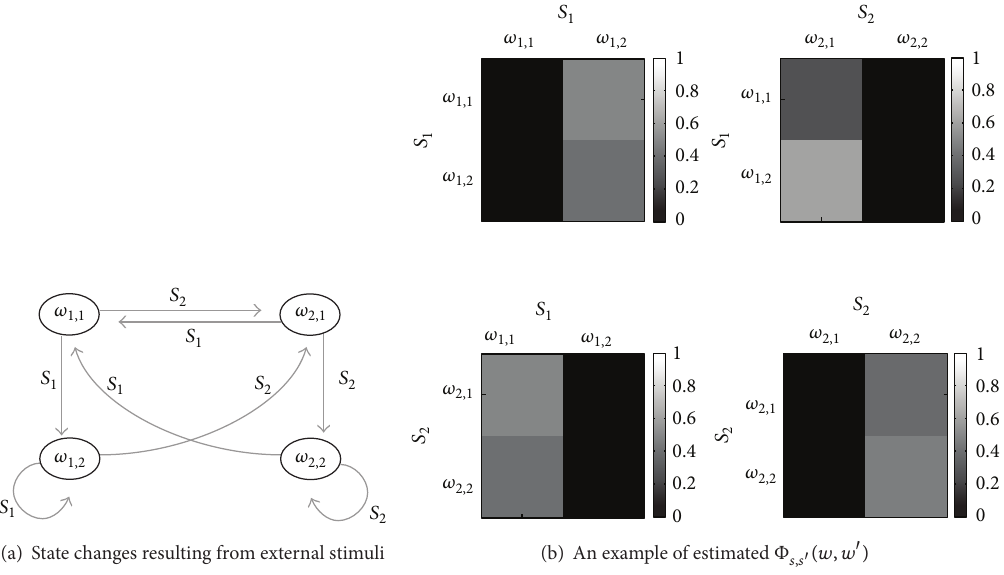
𝑓 for a specific stimulus 𝑆 𝑘 . (b) 𝑖